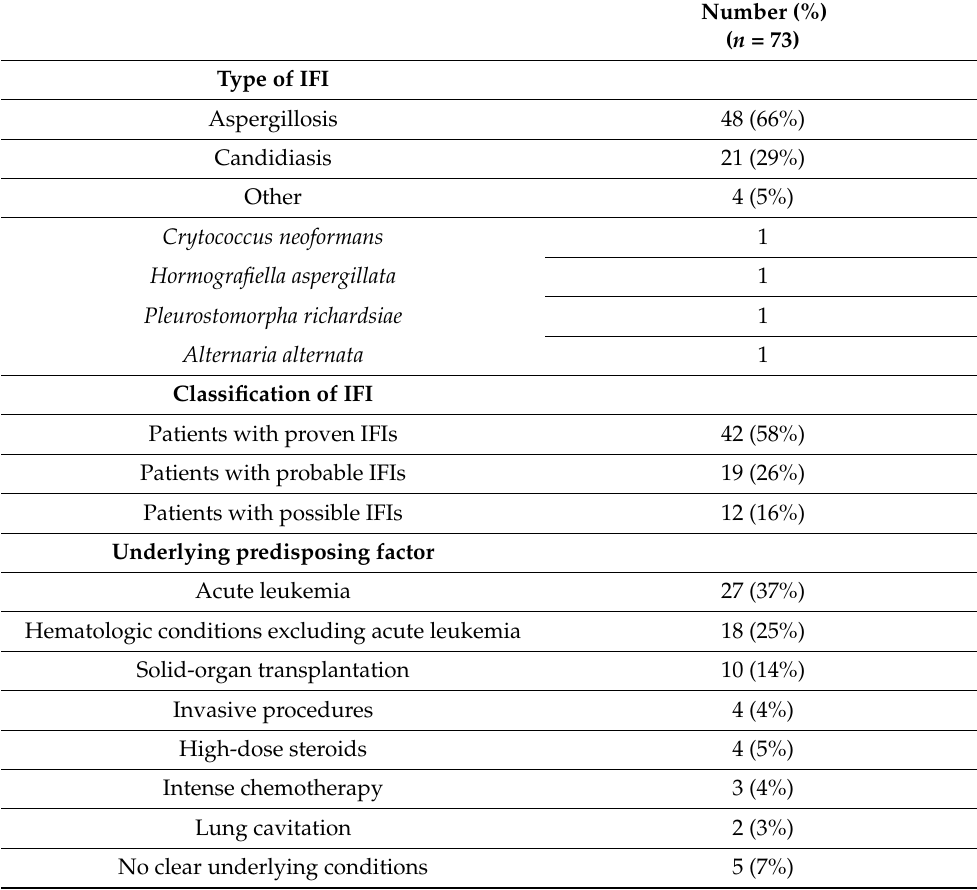
Table 1. Types, classifications and underlying predisposing factors for invasive fungal infections (IFIs).